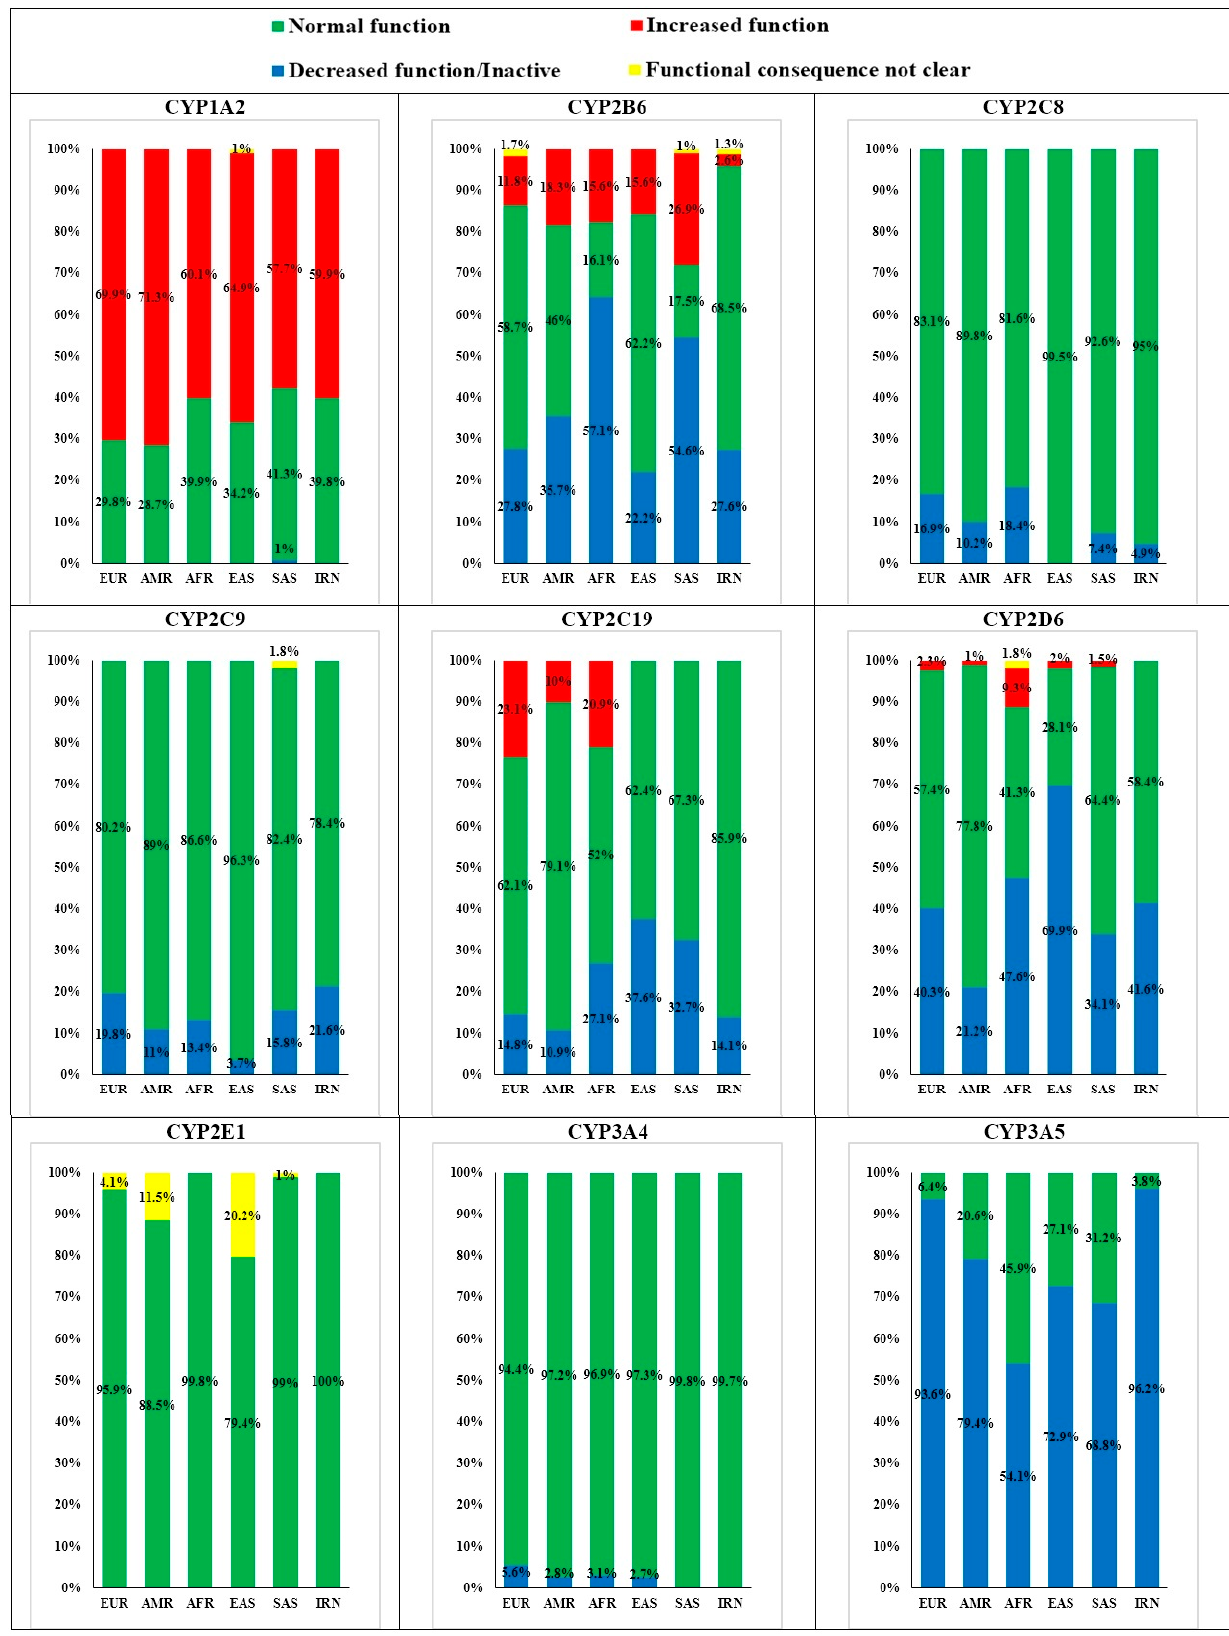
Figure 1. CYP1A2, CYP2B6, CYP2C8, CYP2C9, CYP2C19, CYP2D6, CYP2E1, CYP3A4, and CYP3A5 alleles frequencies in five major populations compared to the Iranian population.